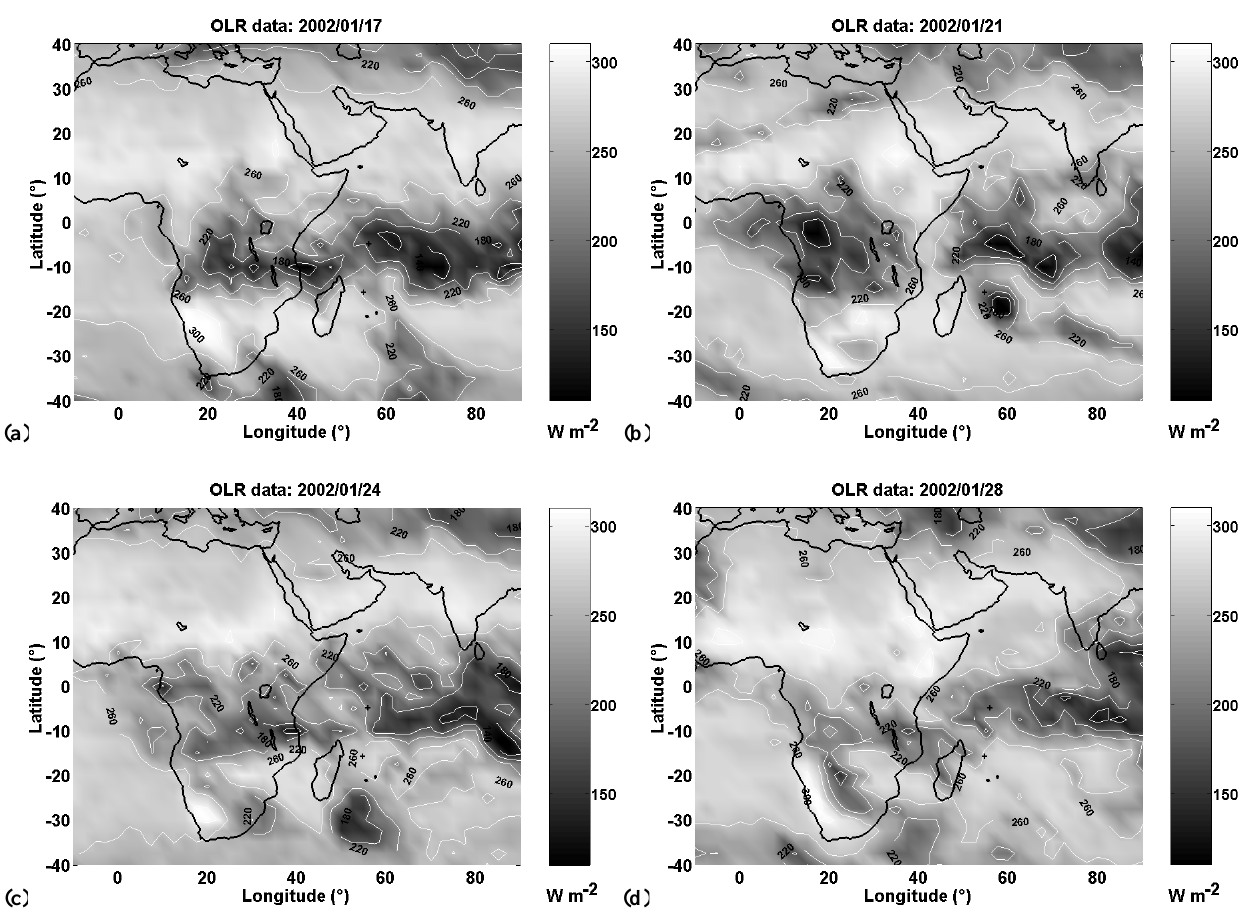
Fig. 7. Maps of 2.5 ◦ –2.5 ◦ gridded NOAA Interpolated Outgoing Longwave Radiation (OLR) at longitudes between − 10 ◦ W and 90 ◦ E and at latitudes between 40 ◦ N and − 40 ◦ S: on (a) 17 January, (b) 21 January, (c) 24 January and (d) 28 January